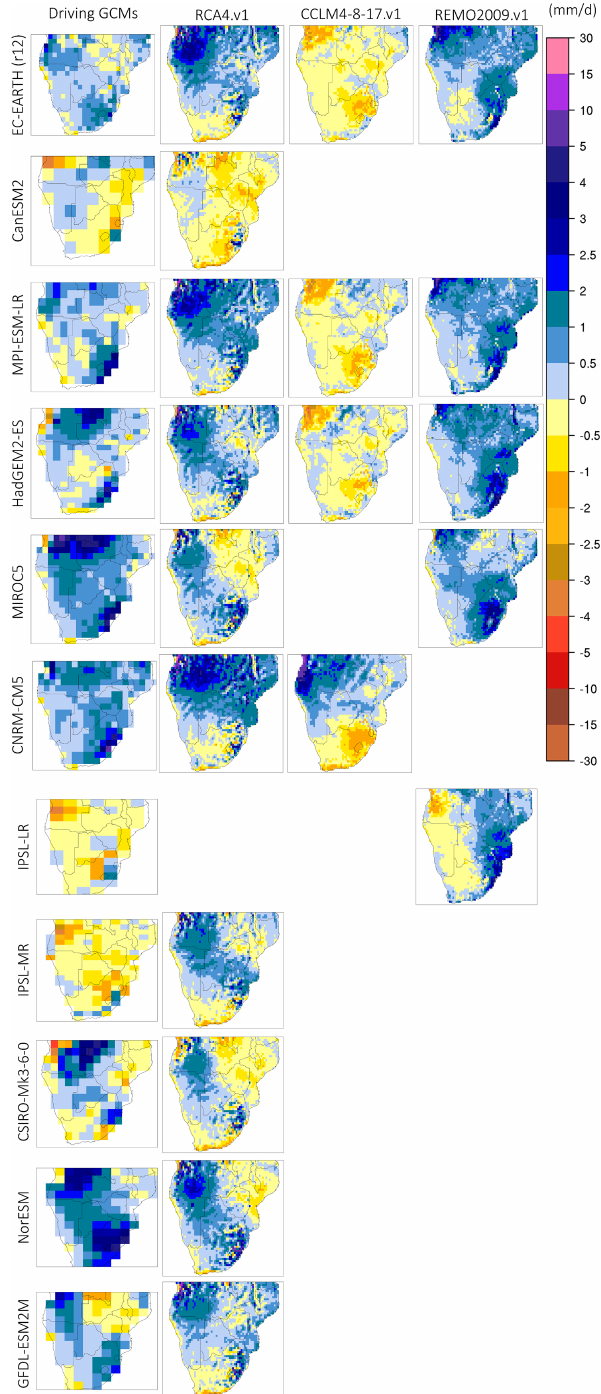
Figure 5. Monthly precipitation bias (model–CHIRPS, in mmd − 1 ) during October for the period 1985–2005. The first column (from the left) displays the biases in the driving GCMs, and columns 2–4 display the biases in the downscaled precipitation output according to RCA4.v1, CCLM4-8-17.v1, and